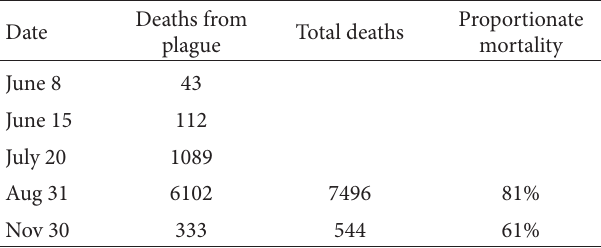
T 4: e �rst epidemic �eld investigation based on the diary of Samuel Pepys during the Great Plague of London, 1665